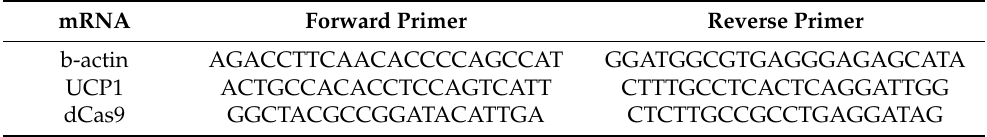
Table 2. Real-time PCR primer